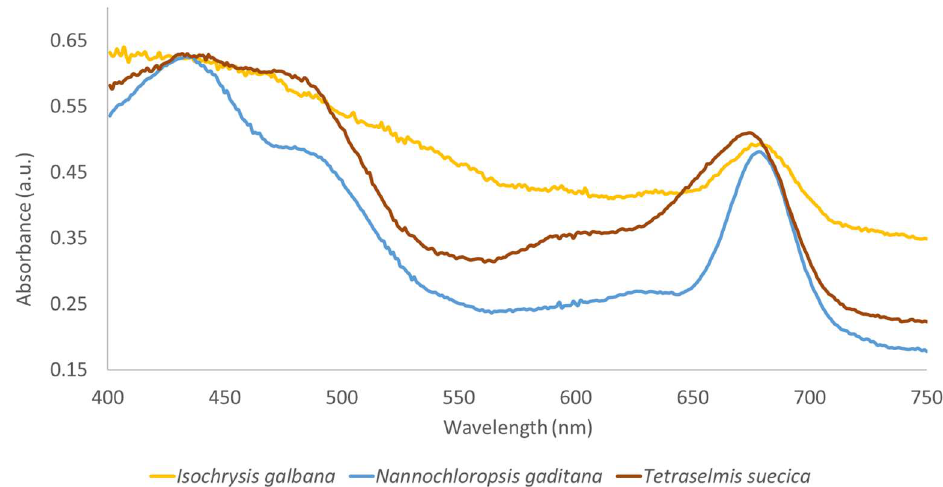
Figure 2. Relative absorbance spectrum of each studied phytoplankton species. All curves were normalized to the same absorbance value at 436 nm. The maximum standard deviation ( n = 3) of 2% was obtained.